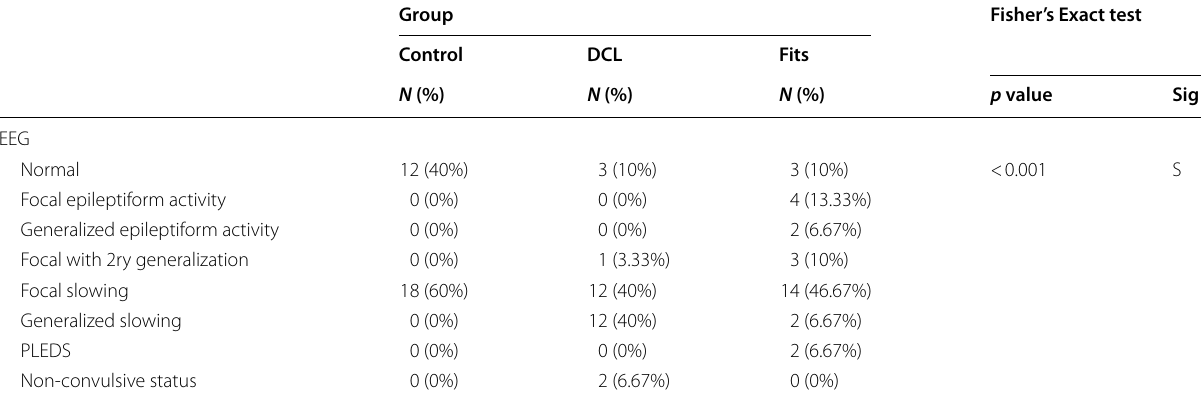
Table 4 Comparison of EEG findings between the three